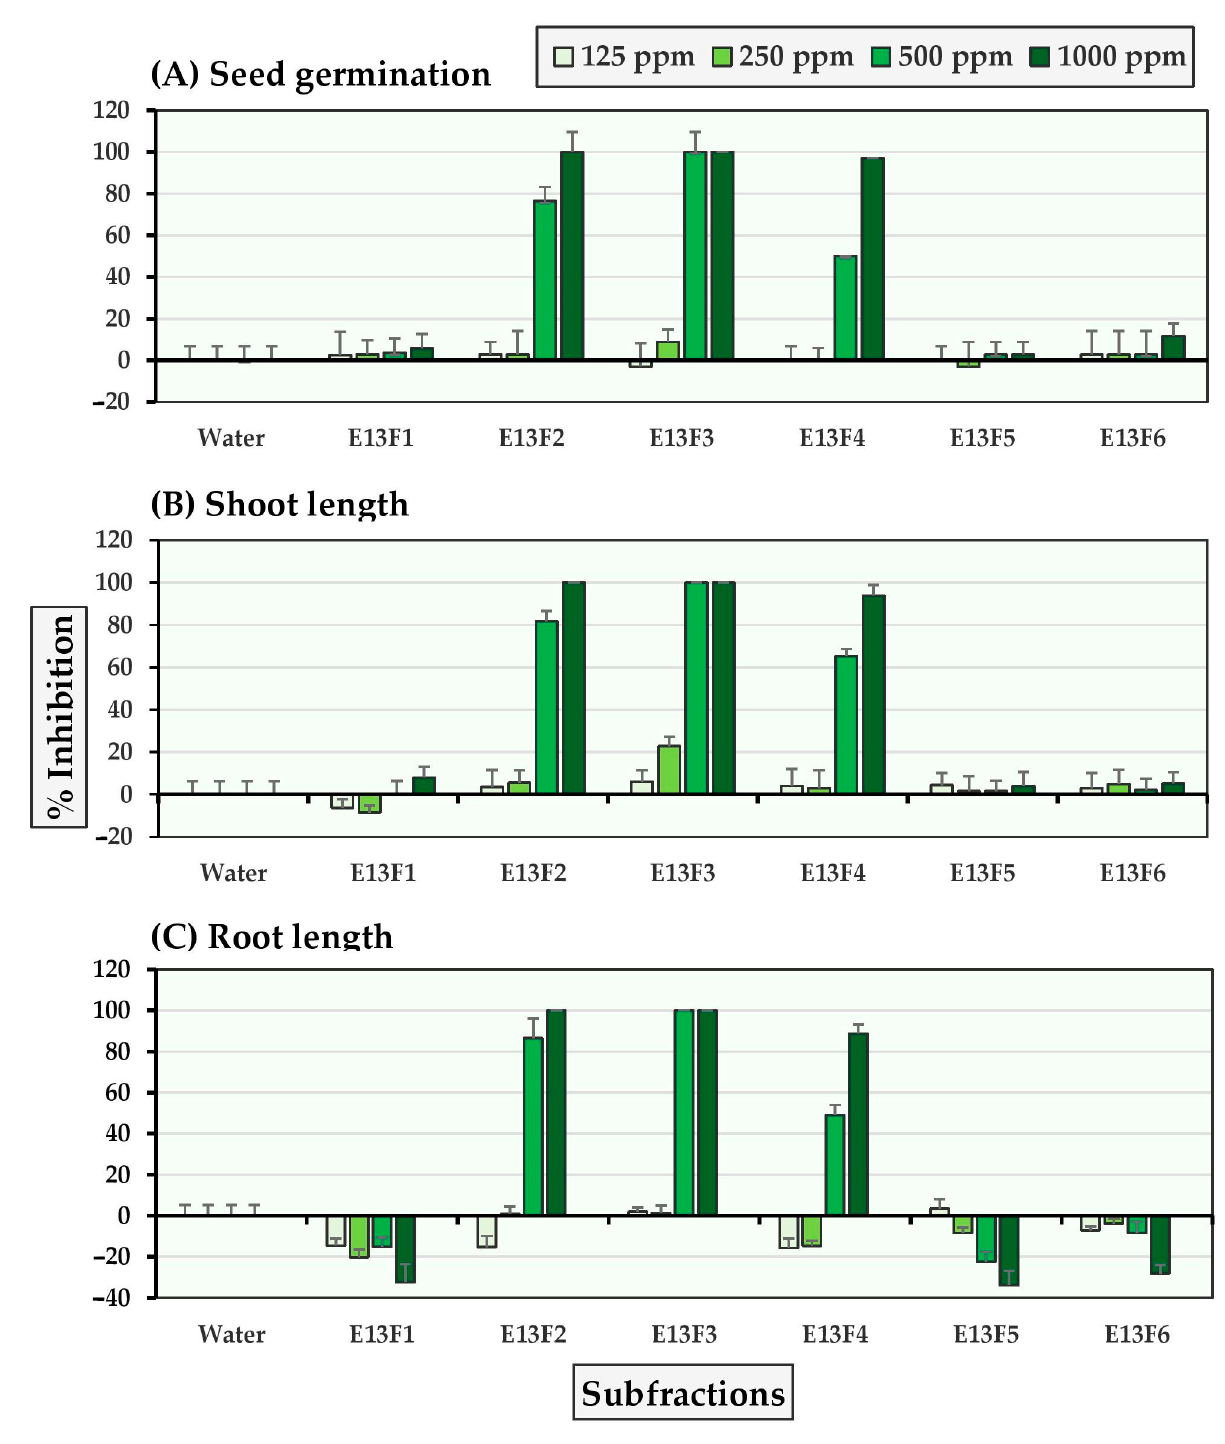
Figure 3. Inhibitory effects of S. platensis E13 subfractions on ( A ) seed germination, ( B ) shoot length, and ( C ) root length of Chinese amaranth. Distilled water was used as a control.